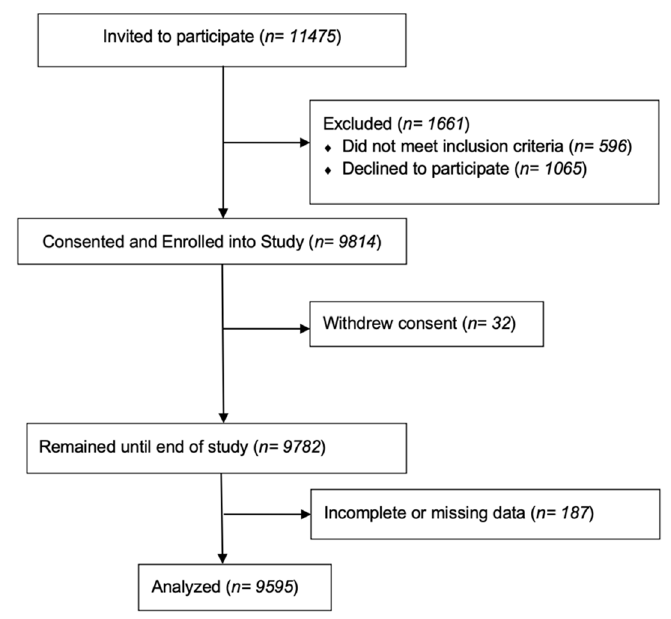
Figure 1. Number of individuals included and excluded at each stage of the study.